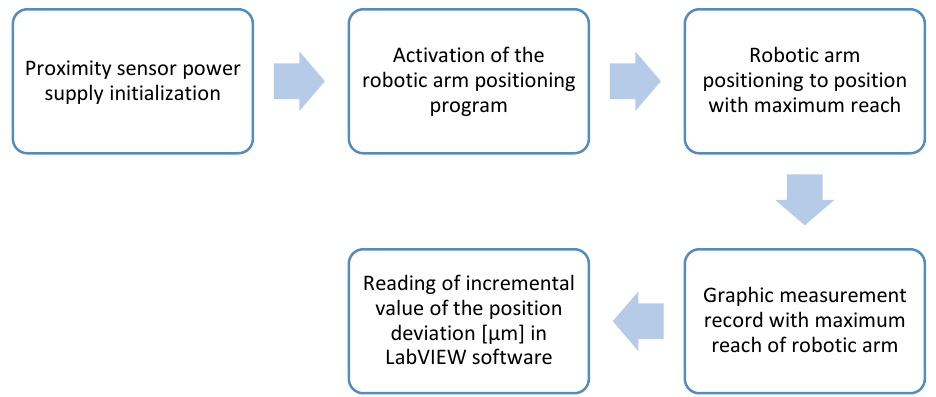
Figure 7. Measuring chain for NcM of robotic arm’s position deviation.